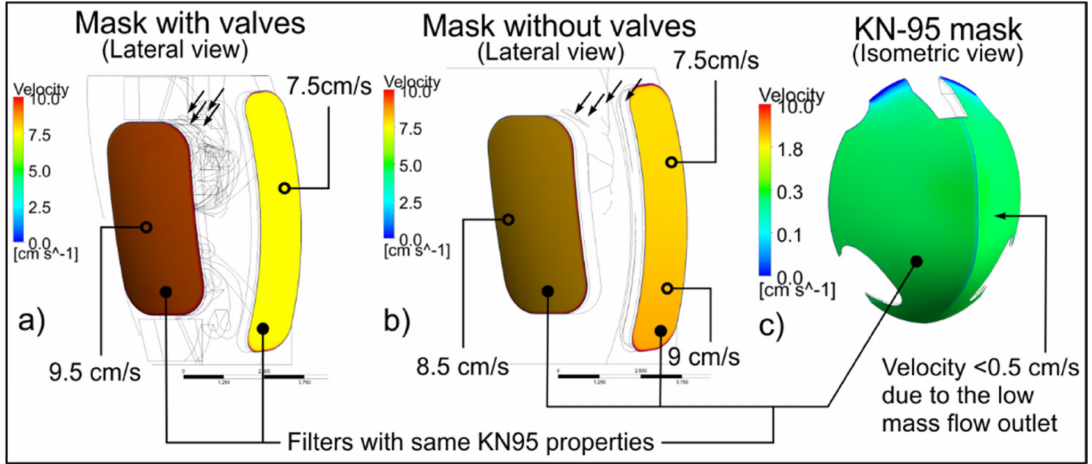
Figure 12. Contours of velocity at boundaries for each mask considering the same porous media properties. Exhalation event through nose at 3.5 m/s. ( a ) case with static valves; ( b ) case without static valves; ( c ) KN95 mask case.